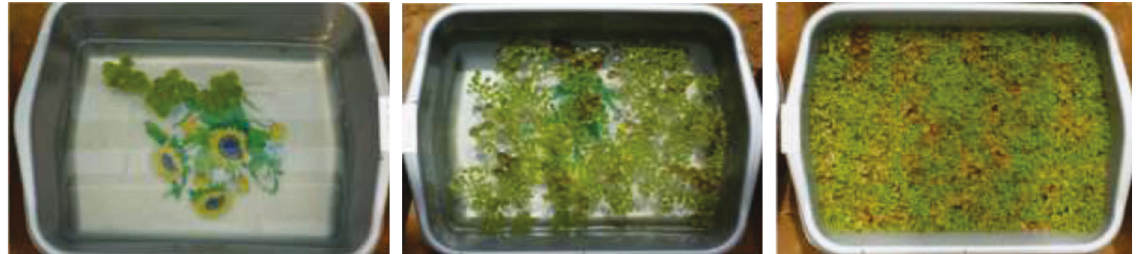
Figure 1: The evaluation of Salvinia sp. adaptation to Fe concentration in Hoagland nutrient solution media in a 4-liter plastic box within 4 weeks.